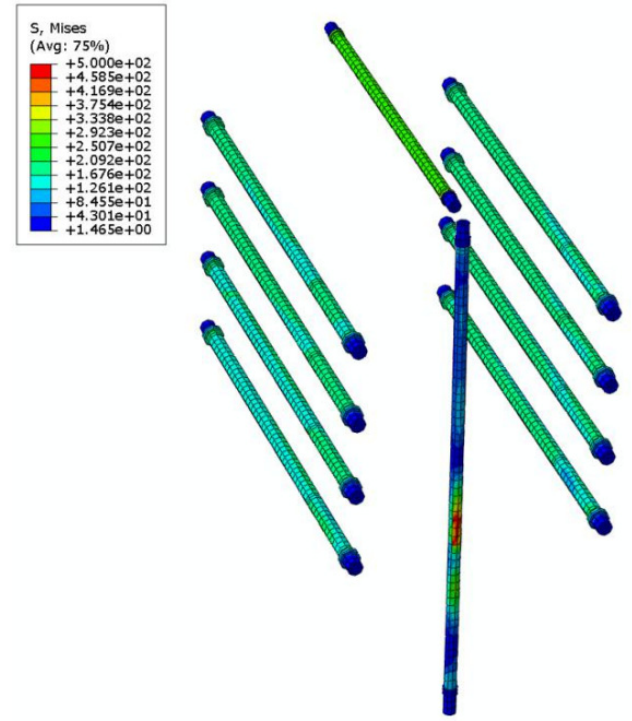
Figure 35. Bolt stress cloud.